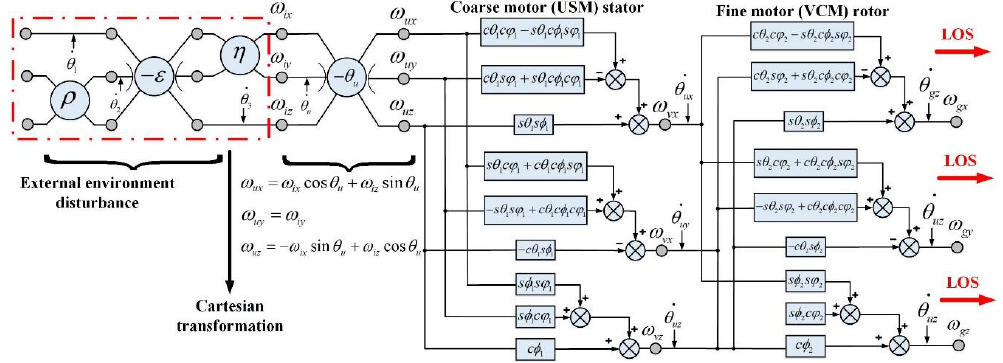
Figure 12. The kinematics coupling relationship of the coarse–fine composite mechatronic system in a UAV multi-gimbal electro-optical pod.